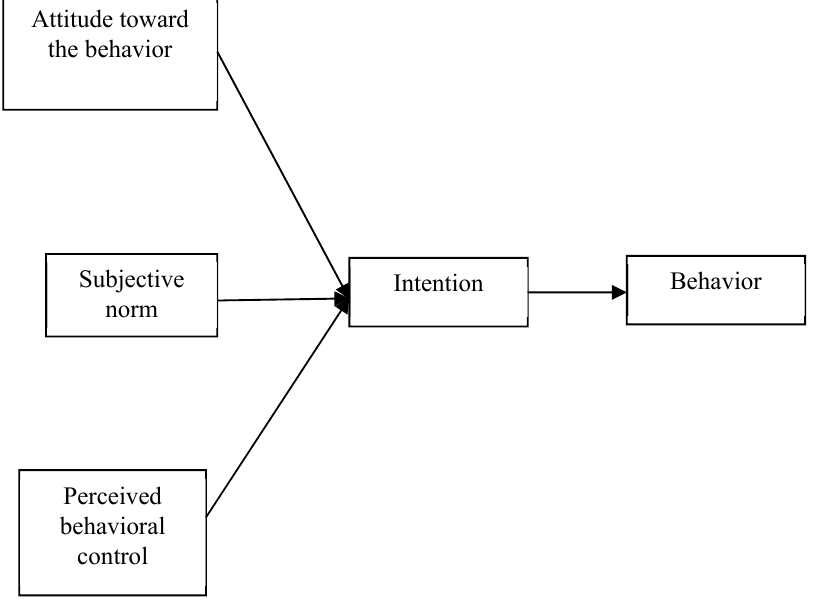
Figure 1. Theory of planned behavior [12].